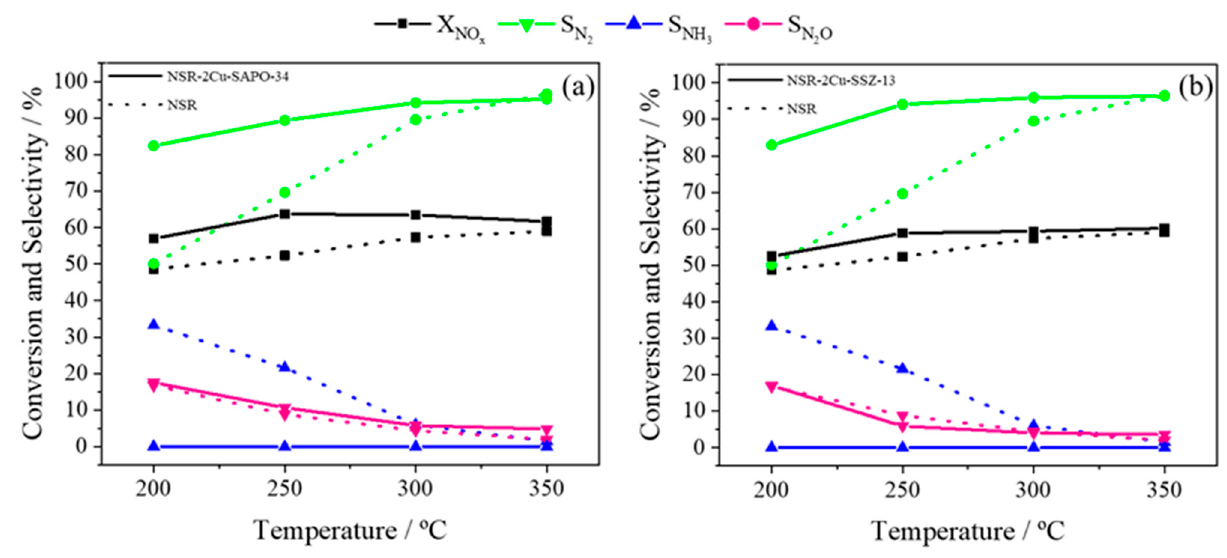
Figure 6. DeNO x activity performance for 0.4Pt-3.5Ba-1.5K/Al2O3 as the NSR system (dotted line) and hybrid NSR–SCR coupled catalytic configuration (solid line): ( a ) NSR-2Cu-SAPO-34 and ( b ) NSR-2Cu-SSZ-13.